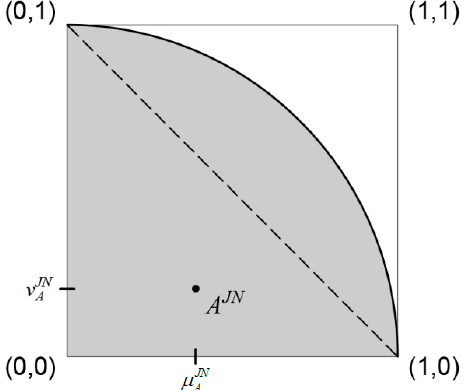
Figure 6. Interpretational surface of IFS-T2/Pythagorean sets/GAIFS6/GIFS-JN for δ = 2/q-ROFS for q = 2/IFS-Tn for n = 2.